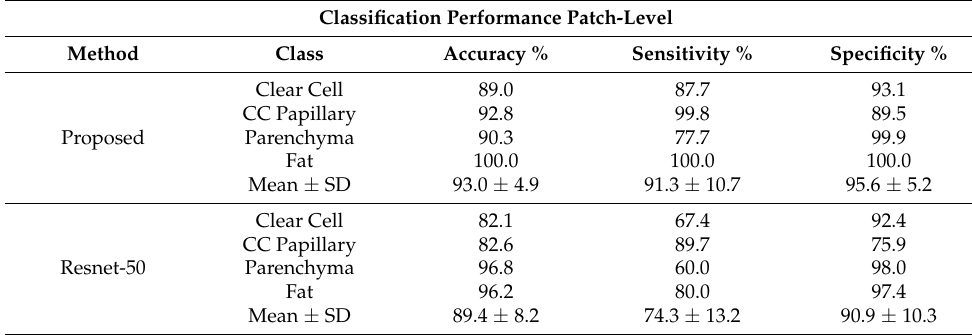
Table 6. Comparison of the classification performance on the patch level.